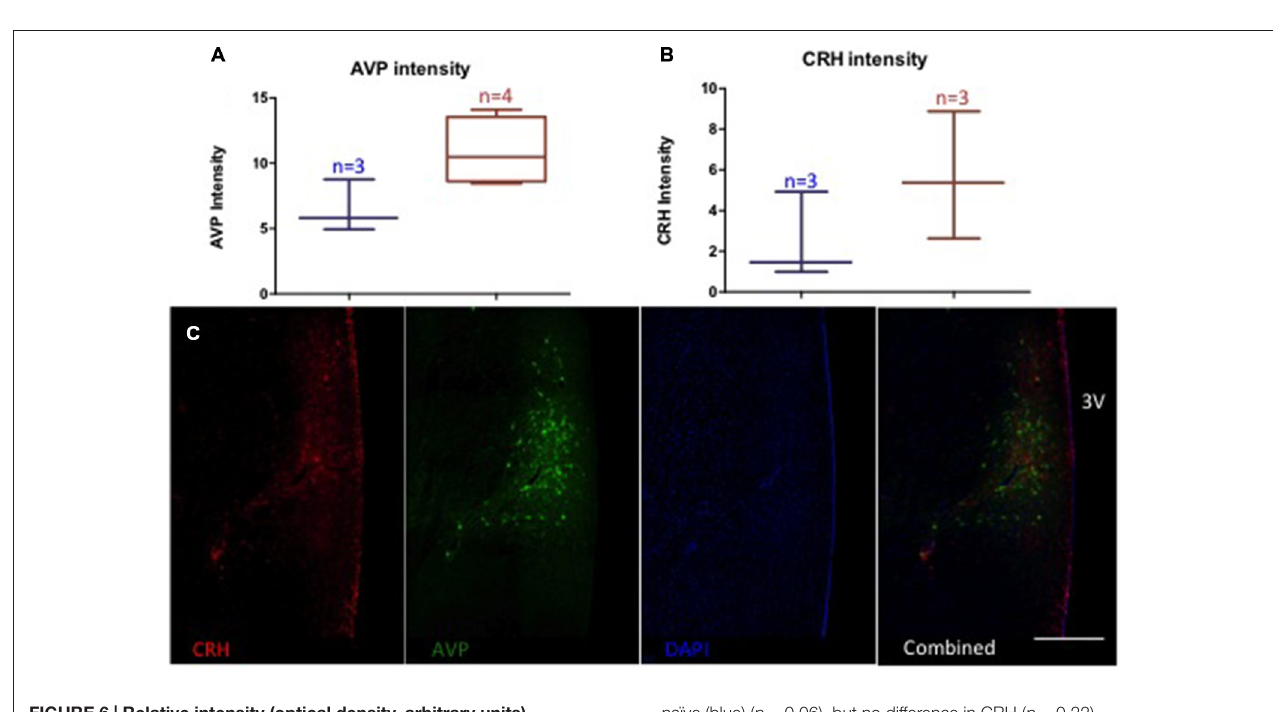
FIGURE 6 | Relative intensity (optical density, arbitrary units) of AVP (A) and CRH (B). A trend towards increased AVP optical density in animals consuming ethanol (red) compared to ethanol